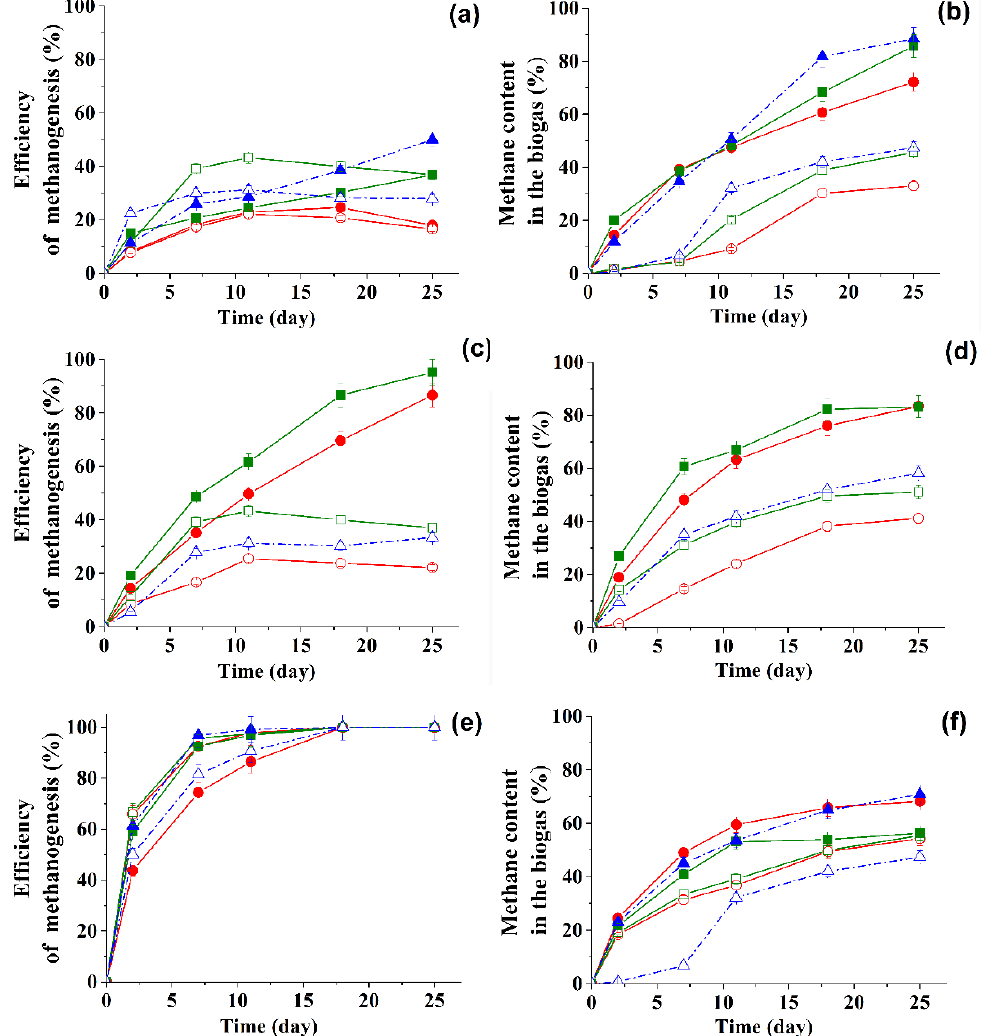
Figure 2. Efficiency of methanogenesis and amount of methane in the accumulated biogas in the course of transformation of 1 g/L glucose and BTO 2 0.15 mM (circles) or DBTO 2 0.15 mM (squares), 0.45 mM (triangles) under the action of free (open symbols) active sludge or PVA cryogel- immobilized (filled symbols) active sludge of Type I ( a , b ), Type II ( c , d ), Type III ( e , f ).